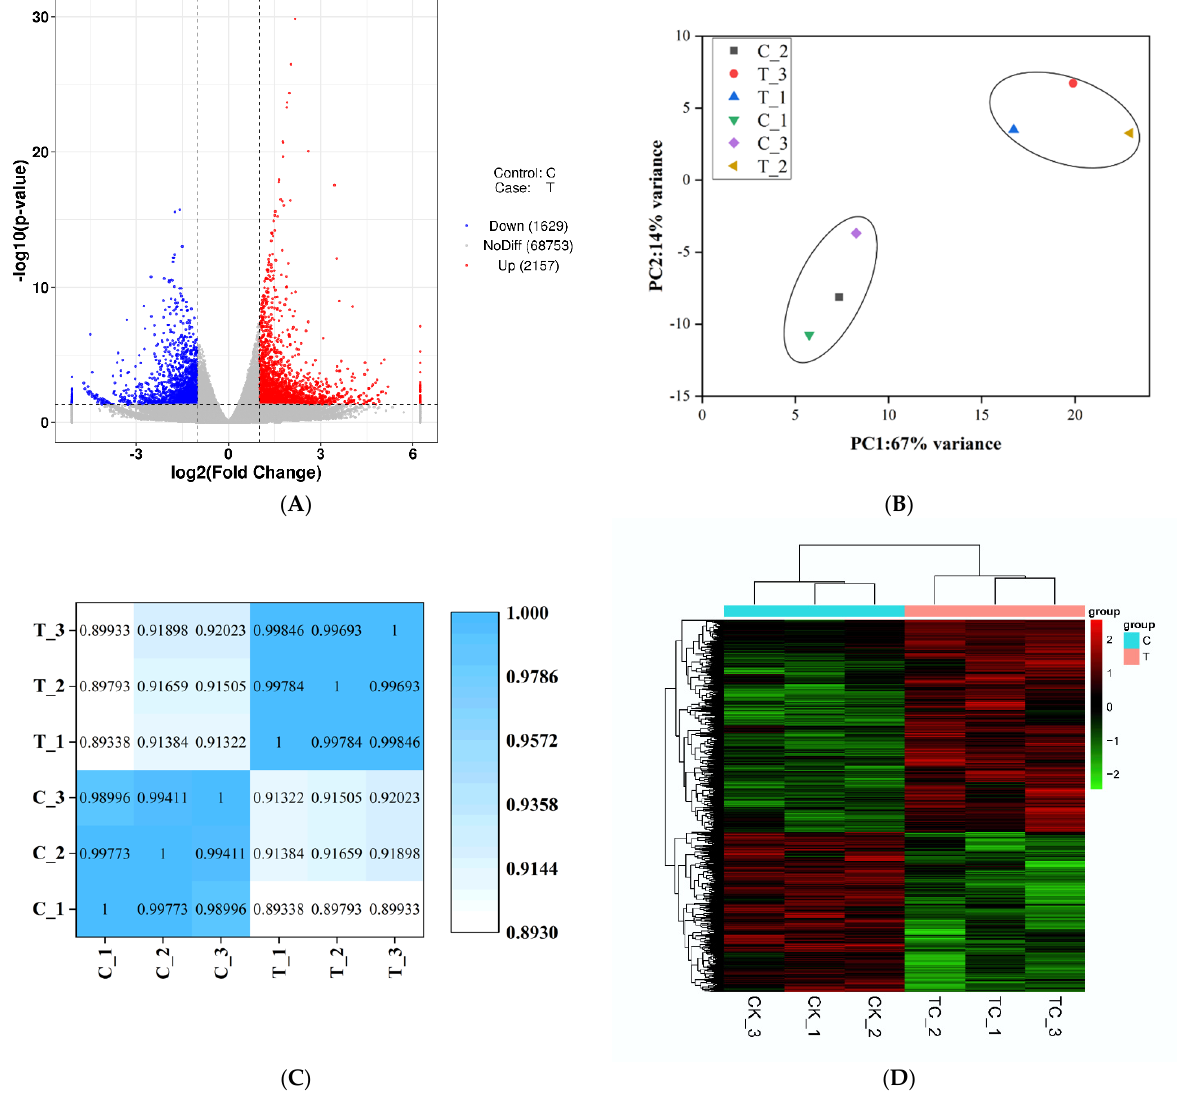
Figure 3. Transcriptomic profiling of Scenedesmus obliquus in the control (C) and tetracycline treatment (T) after 8 d exposure. ( A ) Volcano plot based on the differentially expressed genes (DEGs) in T vs. C groups; ( B ) principal components analysis based on the expression quantity; ( C ) correlation analysis of patterns of gene expression; ( D ) a heatmap of the centered and scaled FPKM values of